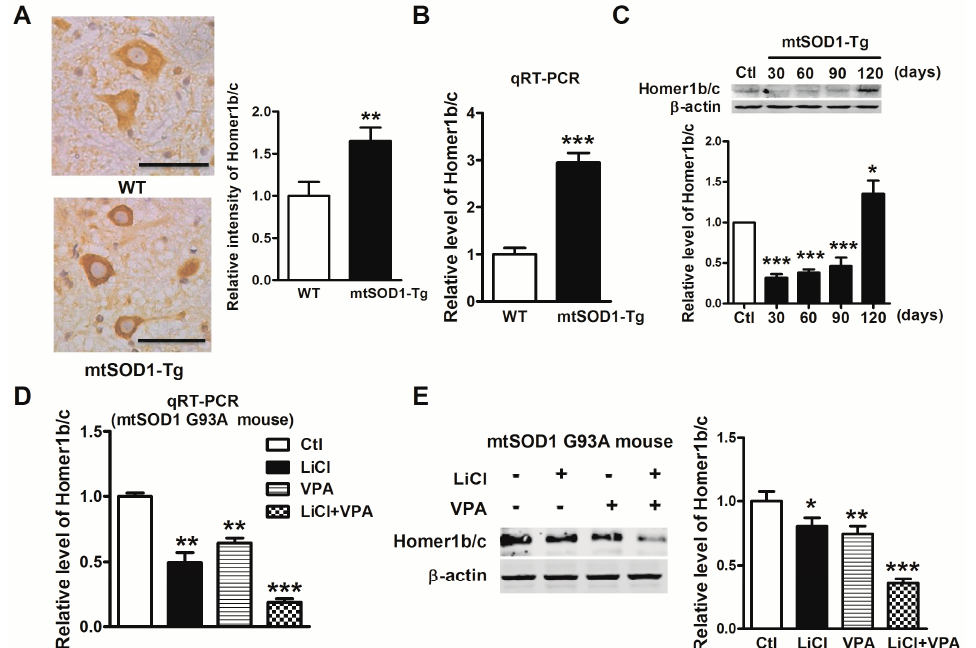
Figure 5. Lithium and VPA suppressed the expression of Homer1b/c in SOD1 G93A transgenic mice. ( A ) Homer1b/c protein positive neurons in the ventral horn of the lumbar spinal cords in both wild type (WT) mice and SOD1 G93A transgenic (mtSOD1-Tg) mice. Homer1b/c protein expression in neurons was detected by immunohistochemistry assay ( left ). Scale bar is 50 µ m. The intensity of Hormer1b/c protein expression in neurons was analyzed by Image-Pro Plus software (Media Cybernetics, Silver Spring, MD, USA) ( right ); ( B ) The mRNA level of Homer1b/c was measured by qRT-PCR of lumbar spinal cords in both WT mice and mtSOD1-Tg mice; ( C ) Western blot detected Homer1b/c protein expression of lumbar spinal cords in WT mice and 30-, 60-, 90-, and 120-day-old mtSOD1-Tg mice; ( D ) qRT-PCR detected the mRNA level of Homer1b/c after treatment with LiCl (intraperitoneal (i.p.) 60 mg/kg), VPA (i.p. 300 mg/kg), and LiCl + VPA (i.p. LiCl 60 mg/kg + VPA 300 mg/kg) for 100 days in mtSOD1-Tg mice; ( E ) Homer1b/c protein expression was analyzed by Western blot in mtSOD1-Tg mice treated with LiCl, VPA, and LiCl + VPA for 100 days, + with treatment of the drug, - without treatment of the drug. * p < 0.05 vs. Ctl group, ** p < 0.01 vs. WT group or Ctl group, *** p < 0.001 vs. WT group or Ctl group. n = 5 independent samples for each group.